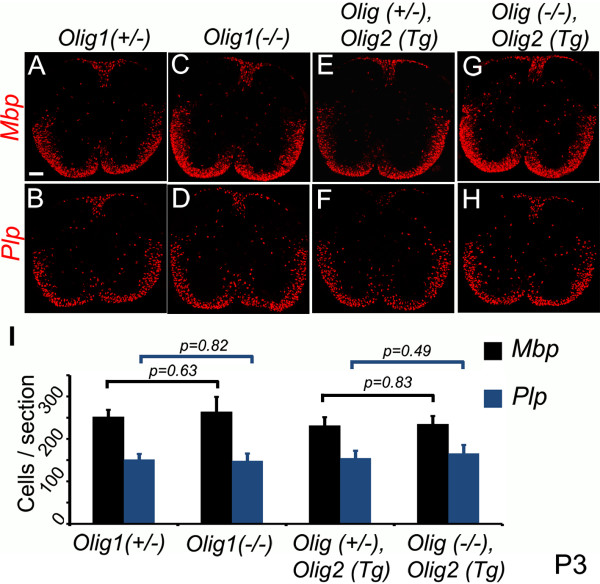
OL numbers recover by P3. At P3, the numbers of Mbp-and Plp-expressing cells in Olig1 null spinal cords (C,D and G,H) were indistinguishable from controls (A,B and E,F respectively). Differentiating OLs were quantified based on Mbp and Plp expression (I). Three sections per mouse (n = 3) were counted and the data displayed as mean ± s.e.m. p values (p < 0.05) were calculated by Student’s t-test. Scale bar: 100 μm.